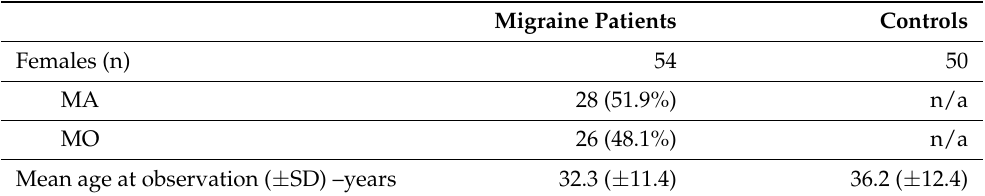
Table 1. Demographic and clinical data of migraine patients and controls. Migraine Patients